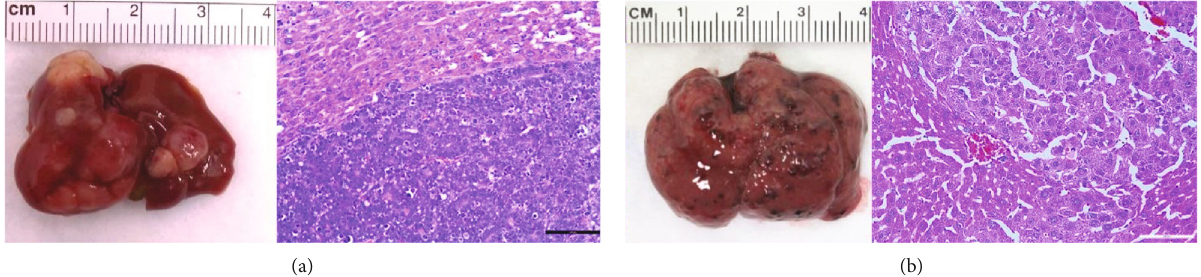
Figure 1: Liver tumor in MYC (a) and MET (b) models with accompanying H&E stains.